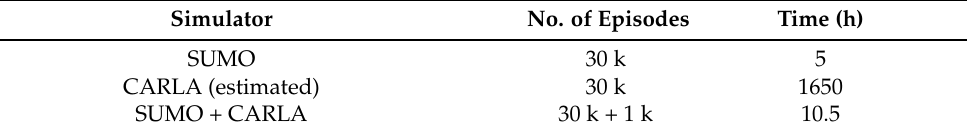
Table 6. Simulation